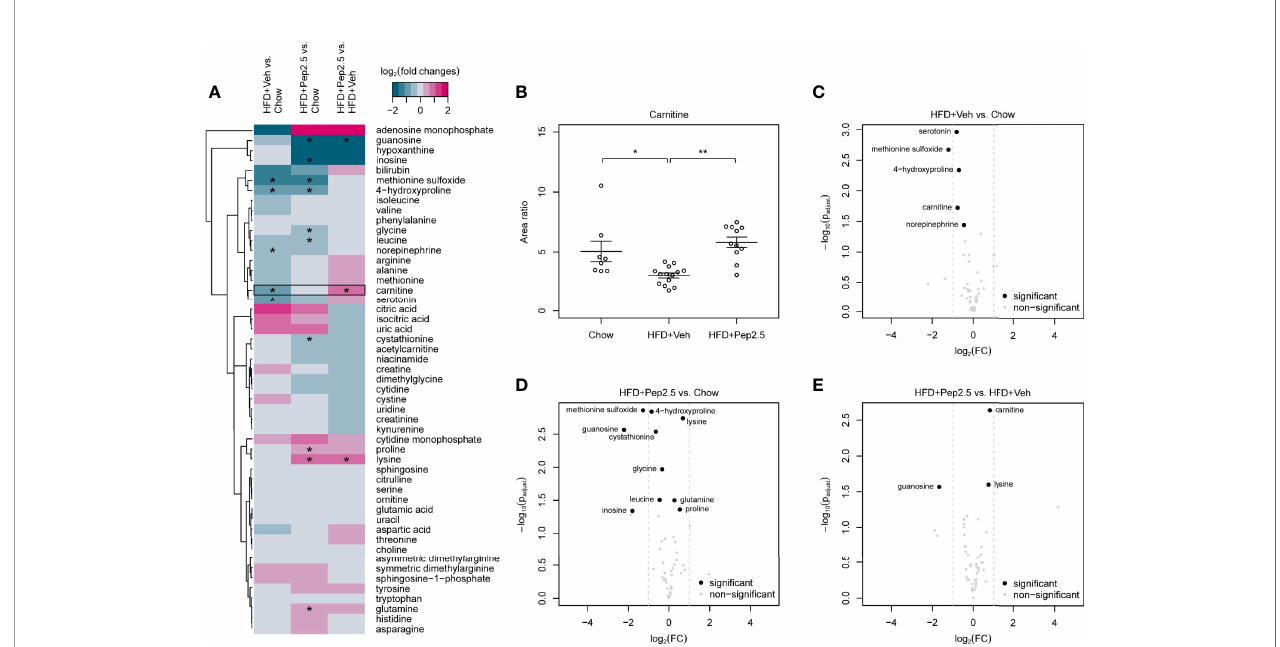
FIGURE 9 | Effect of peptide 19-2.5 administration on primary metabolites in the serum of HFD-fed mice at week 12. HFD-fed mice received either vehicle or peptide 19-2.5. Metabolome analysis was performed on serum samples. Chow (n = 8), HFD+Veh (n = 13), HFD+Pep2.5 (n = 11). (A) Heatmap of all detected primary metabolites. Log2 fold changes and P-values*< 0.05 are shown for all tested groupwise comparisons: HFD+Veh vs. chow, HFD+Pep2.5 vs. chow and HFD+Pep2.5 vs. HFD+Veh. Each column represents a groupwise comparison and each row de fi nes an analyte. Analytes were hierarchically clustered using Ward ’ s minimum variance method (26) and an euclidian distance between log2 fold changes. Dendrograms provide information about distances between clusters. Black frames show analytes with signi fi cant differences between the chow and HFD+Veh group as well as that between the HFD+Veh and HFD+Pep2.5 group. (B) Dot plot of carnitine shows restored levels in HFD-fed mice treated with peptide 19-2.5. Area ratios were calculated by dividing peak area of carnitine by peak area of the related internal standard. Data expressed as mean ± SEM for n number of observations. *P < 0.05 and **P < 0.01 vs. HFD+Veh. (C – E) Volcano plots of primary metabolites. Volcano plots of all tested groupwise comparisons for primary metabolites showing log2 fold changes and adjusted P-values of groupwise comparisons. (C) HFD+Veh vs. chow, (D) HFD+Pep2.5 vs. chow and (E) HFD+Pep2.5 vs. HFD+Veh. Signi fi cantly different analytes are depicted as black circles. Grey dots represent analytes that were not signi fi cantly different for the respective comparison. Grey dashed lines indicate absolute log2 fold change of